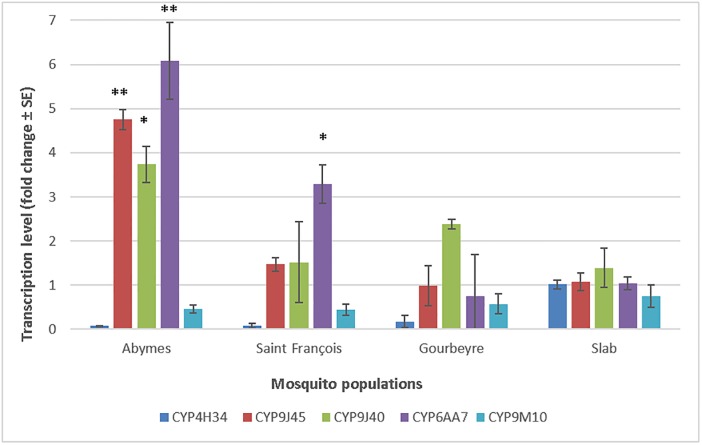
Constitutive transcription levels of the cytochrome P450 monooxygenase genes CYP4H34, CYP9J45, CYP9J40, CYP6AA7 and CYP9M10 in three Culex quinquefasciatus populations from Guadeloupe compared to the susceptible Slab strain.The transcription ratios obtained from real-time quantitative PCR were normalized with the housekeeping gene RPL8 and shown as mean value (±SE) of three independent biological replicates. Asterisks indicate genes over-transcribed with transcription ratio fold ≥2 and with significant P-values: p<0.05 (*) and p<0.01 (**).